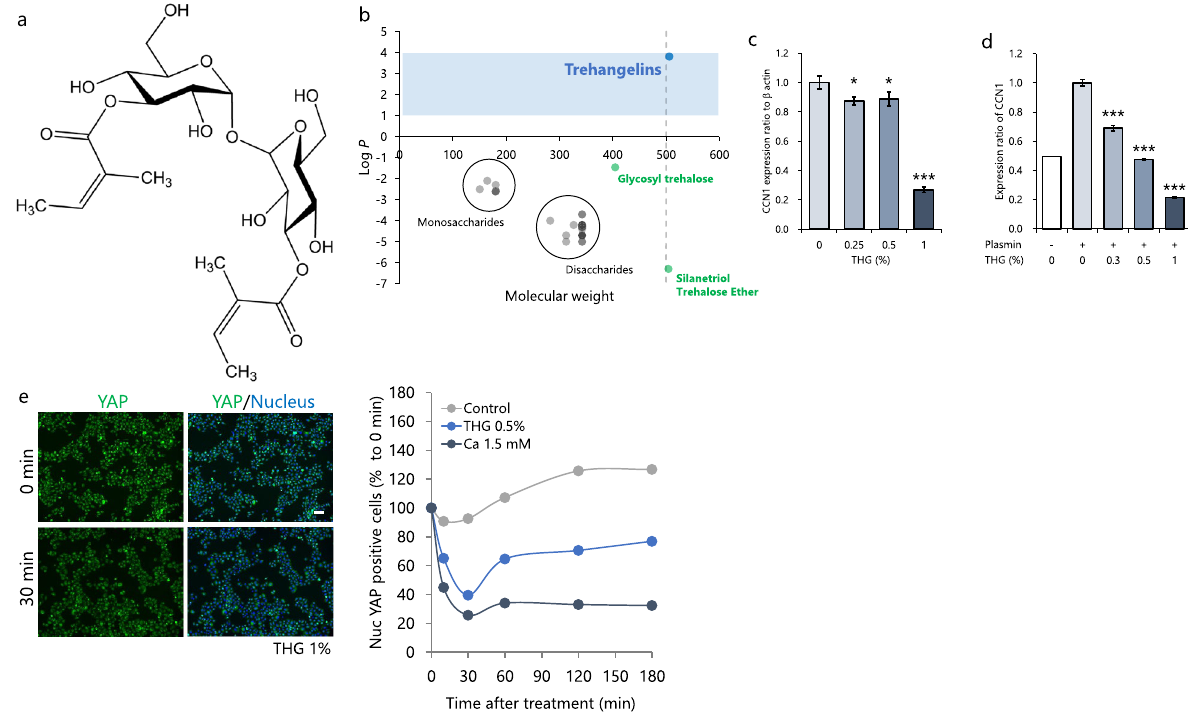
Figure 1. Trehangelins (THG) suppress the expression of CCN1 in keratinocytes by inhibiting the translocation of Yes-associated protein (YAP) to the nucleus. Structure of THG A ( a ). Estimated LogP of THG, Trehalose derivatives and mono/disaccharides was calculated using ChemDraw. Detailed list is shown in Supplementary Information (Table S1) ( b ). Effects of THG on CCN1 expression. Keratinocytes were pretreated with THG for 24 h and then were stimulated with or without 10 U plasmin, after which they were incubated for another 24 h. The expression of cellular CCN1 from the lysate ( c ) and secreted CCN1 from the supernatant ( d ) was determined by Western Blotting and was quantified. Values reported are means ± SD of n = 3 replicates, Dunnett’s test, * p < 0.05, ** p < 0.01, *** p < 0.001 ( c , d ). Immunocytochemistry of YAP and analysis of nuclear YAP-positive cells 0–3 h after Ca or THG treatment ( e ). Values reported are means of n = 10,000 cells, Bar = 100 μm ( e